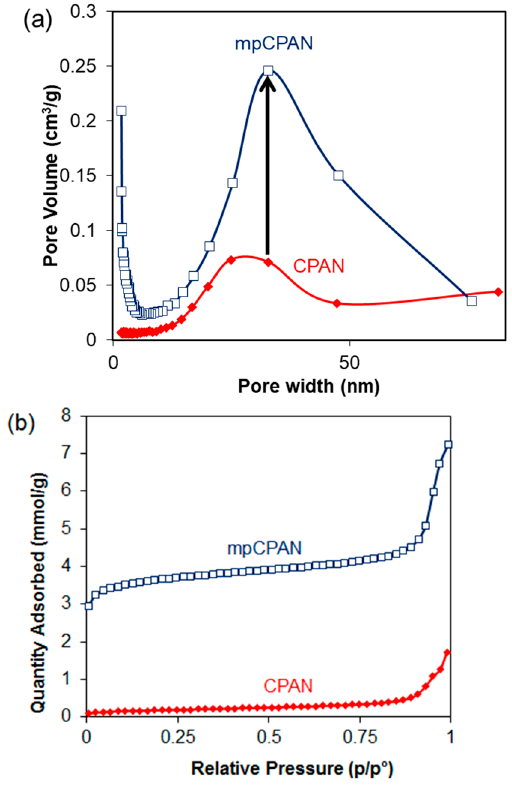
Figure 11. ( a ) Pore-size distribution of CPAN and mpCPAN obtained by the BET surface area anal- ysis; ( b ) Nitrogen adsorption isotherm for CPAN and mpCPAN. ( b ) Nitrogen adsorption isotherm for CPAN and